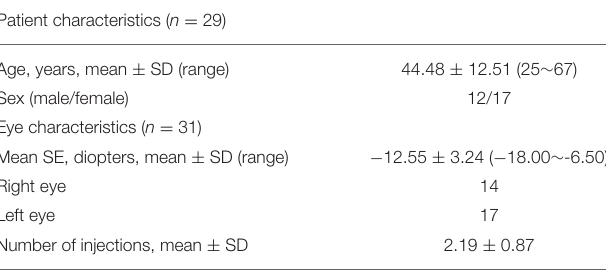
TABLE 1 | Demographic and morphologic characteristics of study population. Patient characteristics ( n = 29)